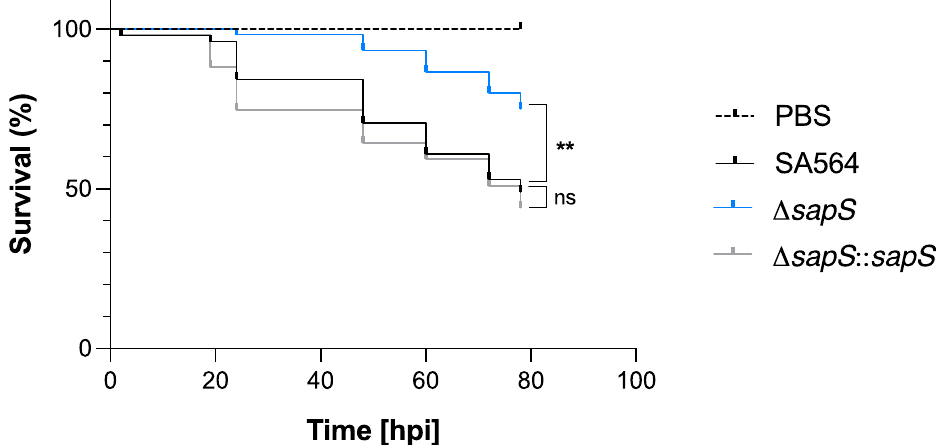
Figure 3. Infected zebrafish embryos display an increased level of survival when infected with the SA564 ∆ sapS mutant. Kaplan–Meier graphic represents the survival of infected zebrafish embryos after injection in the duct of Cuvier with SA564 (black symbols), SA564 ∆ sapS (blue symbols), and SA564 ∆ sapS::sapS (grey symbols) strains at 3 × 10 2 CFU/nL grown in exponential phase, or PBS (negative control) The proportion of surviving embryos (n = 50 for each, indicative of three different experiments) is represented. **, p < 0.01, ns, not significant (Log-rank Mantel–Cox statistical test). hpi, hours post-infection.